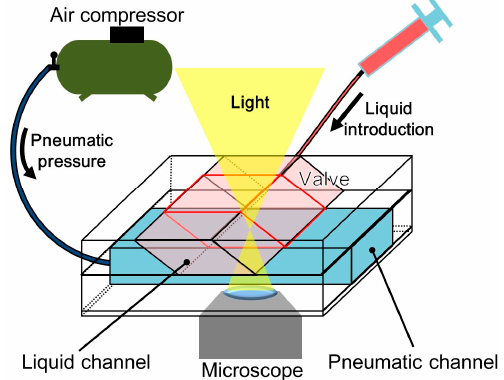
Figure 6. Experimental setup.